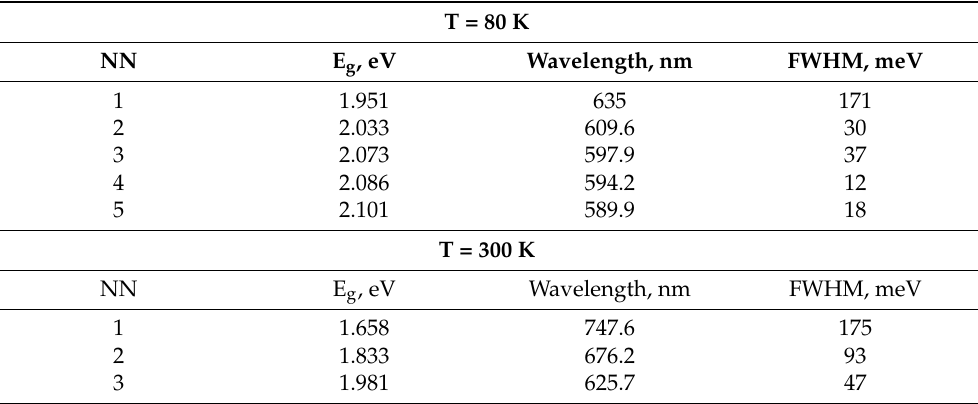
Table 3. The result of decomposition into Gaussian components for the PL line in the GaSe crystal with an ARM.